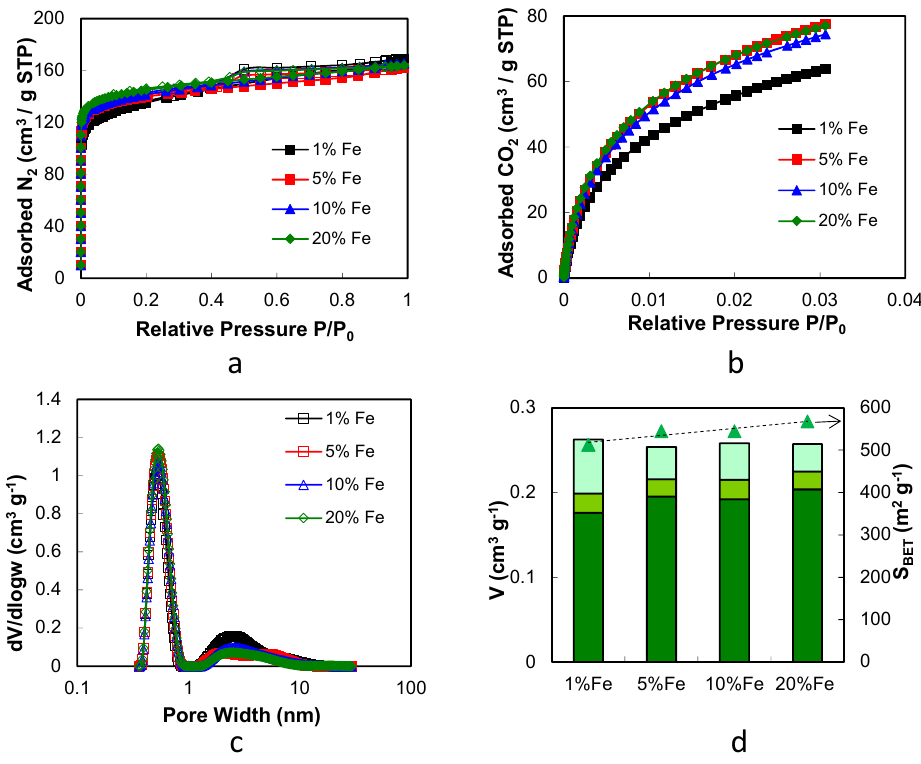
Figure 13. ( a ) Nitrogen adsorption–desorption isotherms (full and open symbols, respectively) at − 196 °C for all samples after HTC and subsequent pyrolysis at 900 °C; ( b ) CO 2 adsorption isotherms at 0 °C for the same materials as in ( a ); ( c ) Pore size distributions determined by application of the NLDFT model to the data shown in ( a ) and ( b ); ( d ) Corresponding pore volumes classified according to their sizes: narrower than 0.7 nm (ultramicropores), between 0.7 and 2 nm (supermicropores); and between 2 and 50 nm (mesopores). Table 2. Textural properties measured for porous carbons loaded with